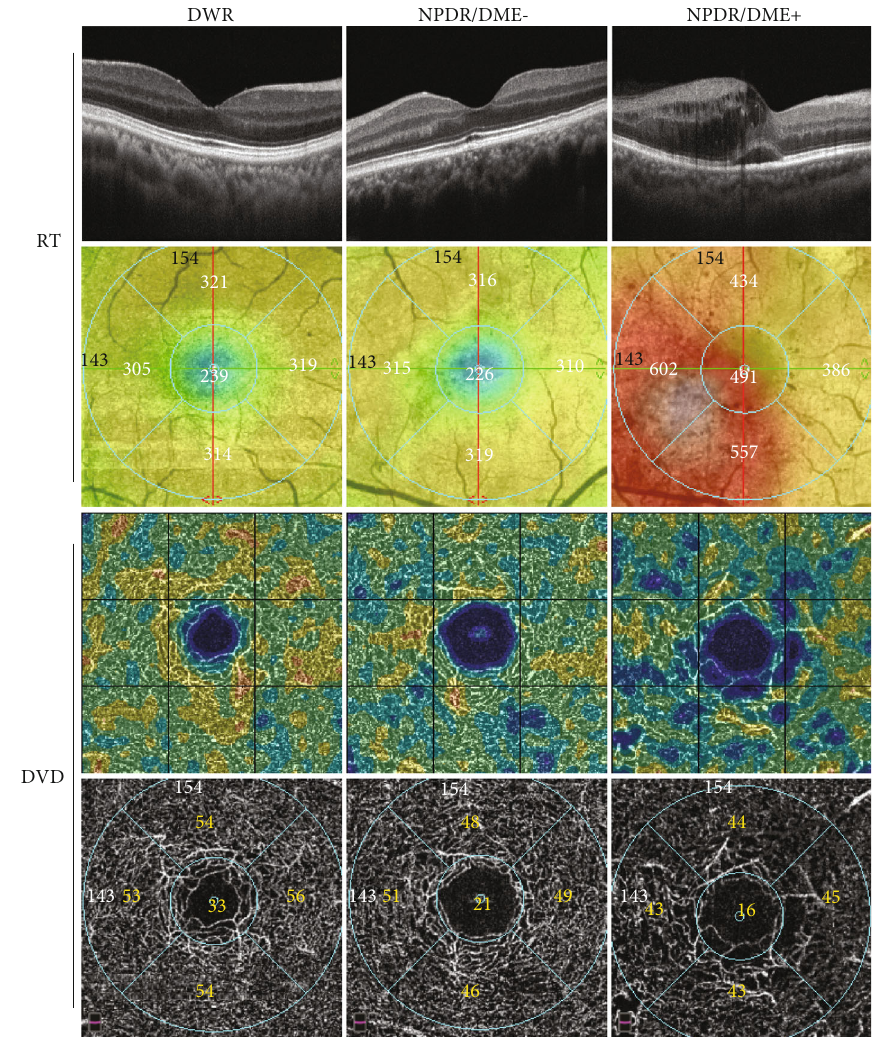
Figure 1: OCTA images of the three groups. Compared with DWR and NPDR/DME- groups, RT was signi fi cantly increased and DVD was signi fi cantly decreased in NPDR/DME+